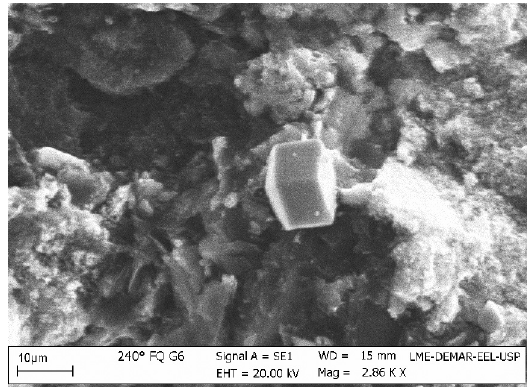
Figure 4. Detailed rhombohedral sulfur crystal in the bright phase from hot face